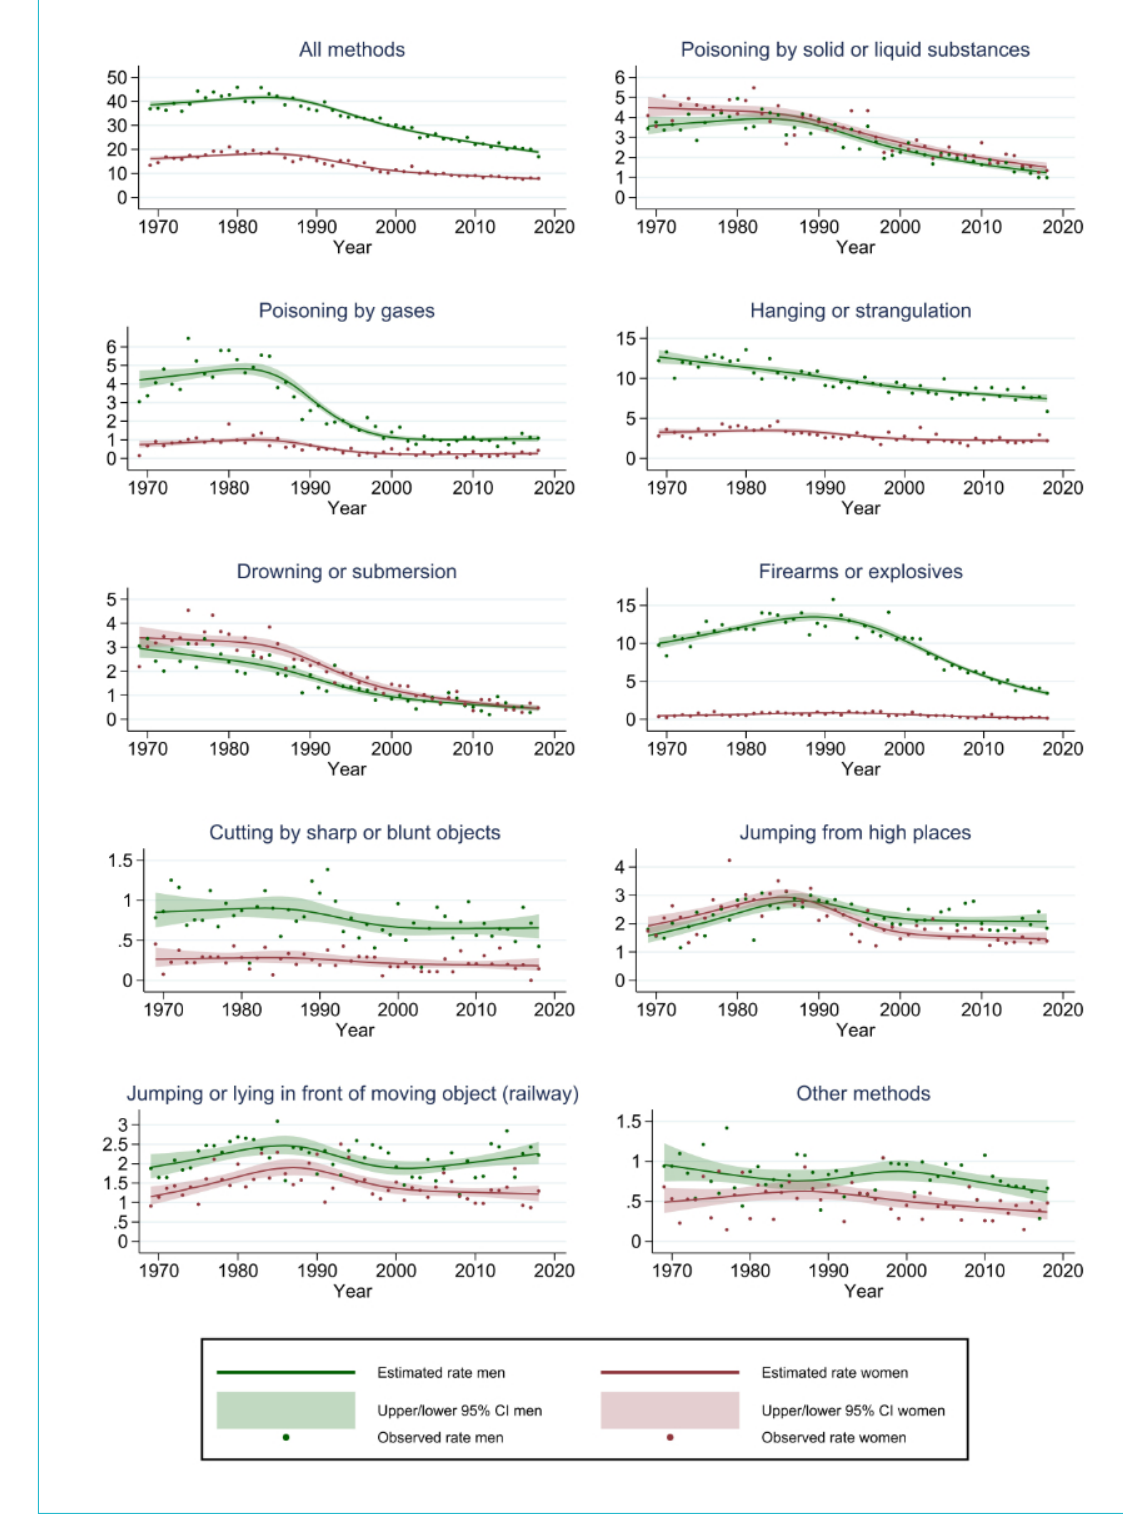
Figure 3: Rates of suicide methods per 100,000 population (person-years) in the age group 30–64 years. Note: estimated true rates and as- sociated confidence intervals (CI) were derived from Poisson regressions using a restricted cubic-spline